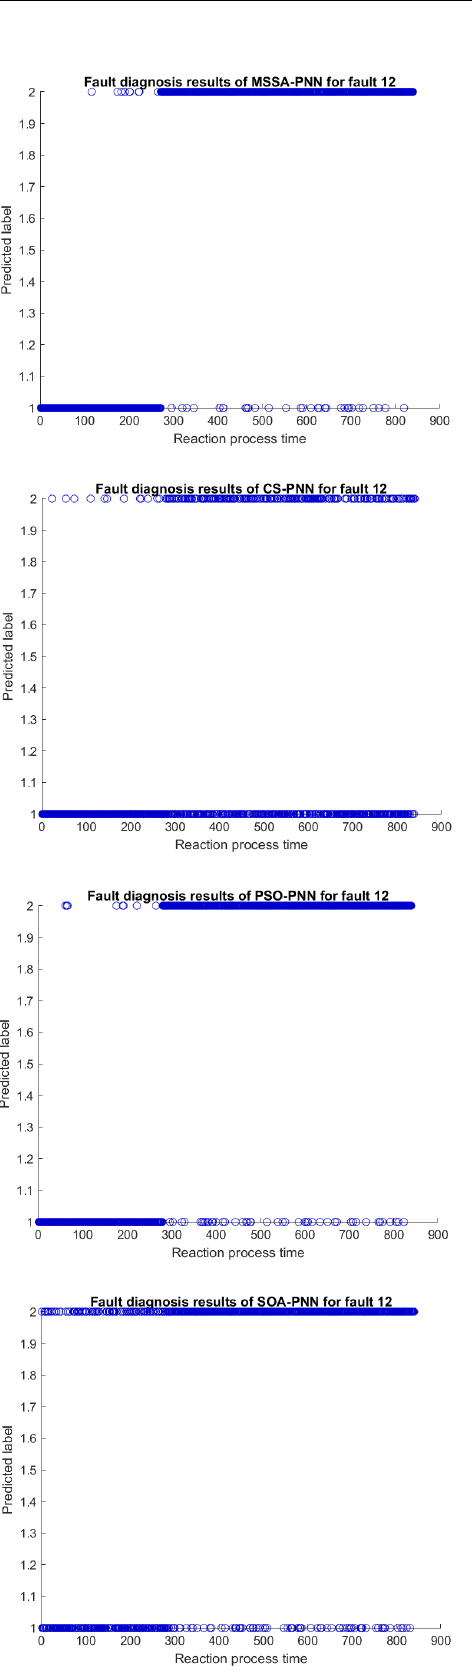
Figure 6. Monitoring performances for Fault